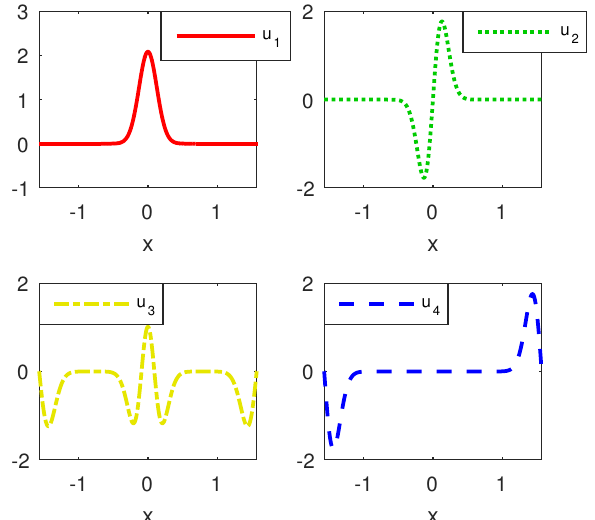
Figure 2. The first four eigenvectors of the Coffey-Evans problem computed by Chebfun.